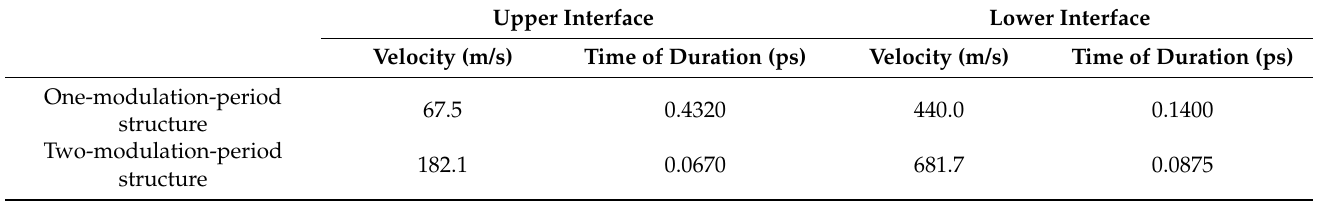
Table 2. Linear propagation rates and durations of the upper and lower diffusion fronts of nano Al/CuO energetic composite films with different configurations.